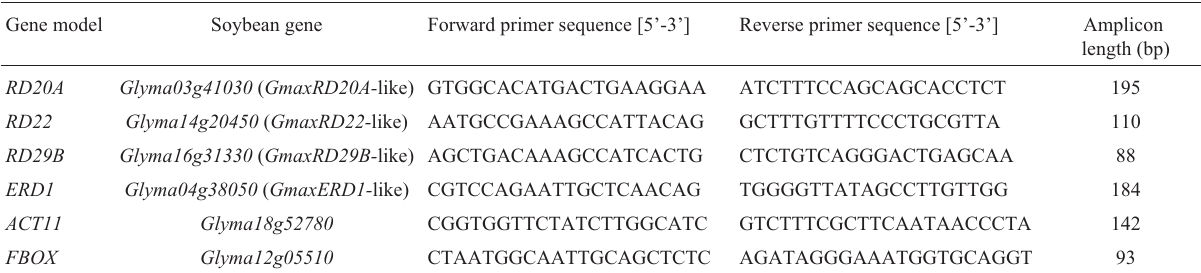
Table 1 - Primer sequences used in the qPCR protocols and amplicon